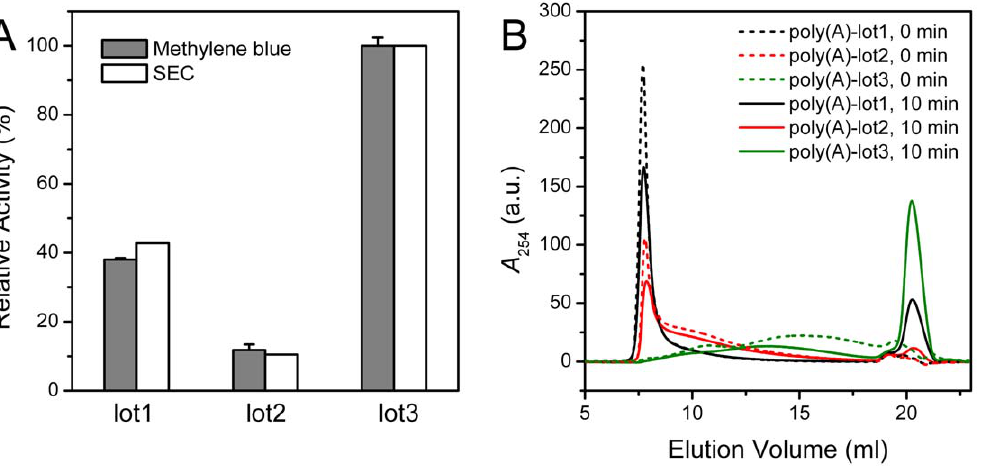
Figure 4. Relative activities of PARN when using the three lots of commercial poly(A) as the substrate. (A) Activities determined by the methylene blue and SEC assay. The mass concentration of poly(A) were all 100 m g/ml. The final concentration of enzyme was 0.04 mg/ml, and the reaction time was 10 min. (B) SEC profiles of the reaction solutions quenched at 0 and 10 min using the three lots of poly(A) as the substrate.